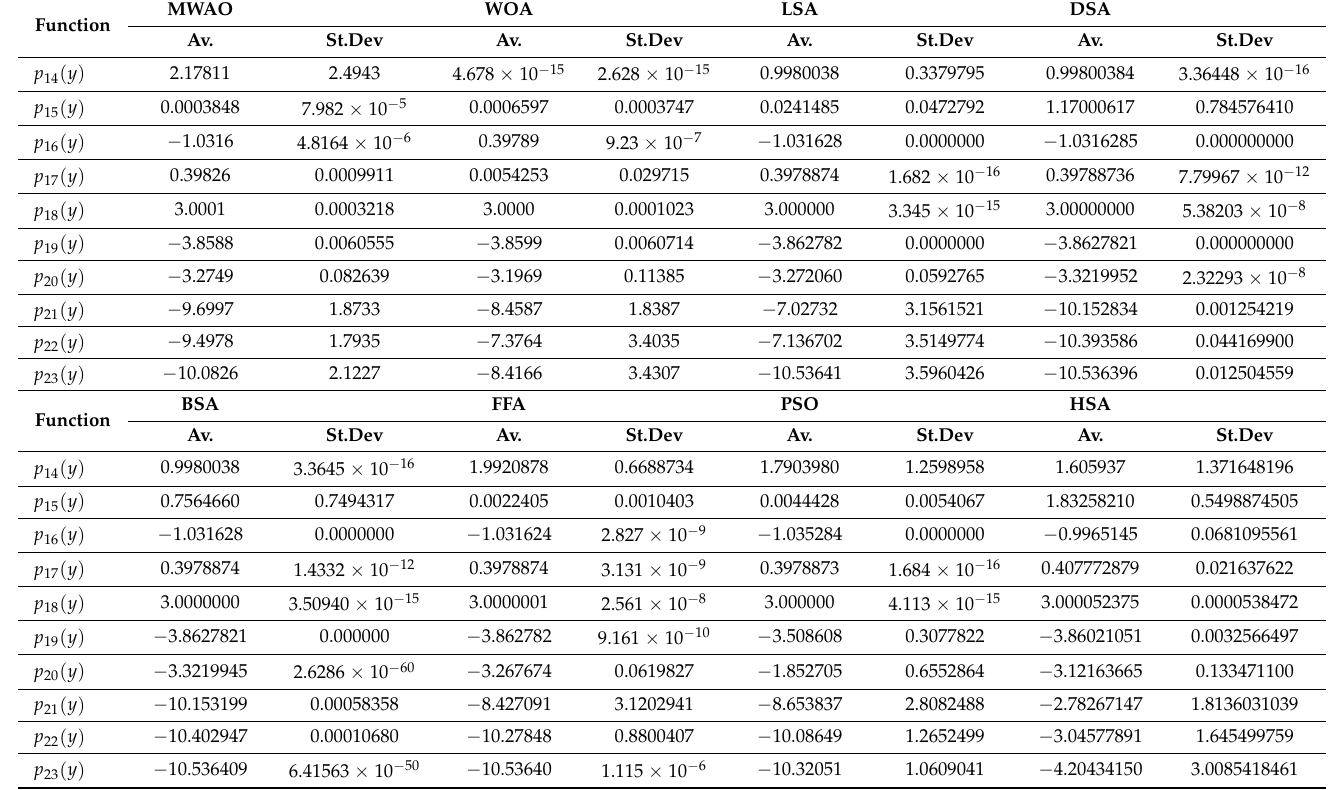
Table 6. Statistical result of different algorithms derived for 50 runs on fixed-dimensional multimodal benchmark